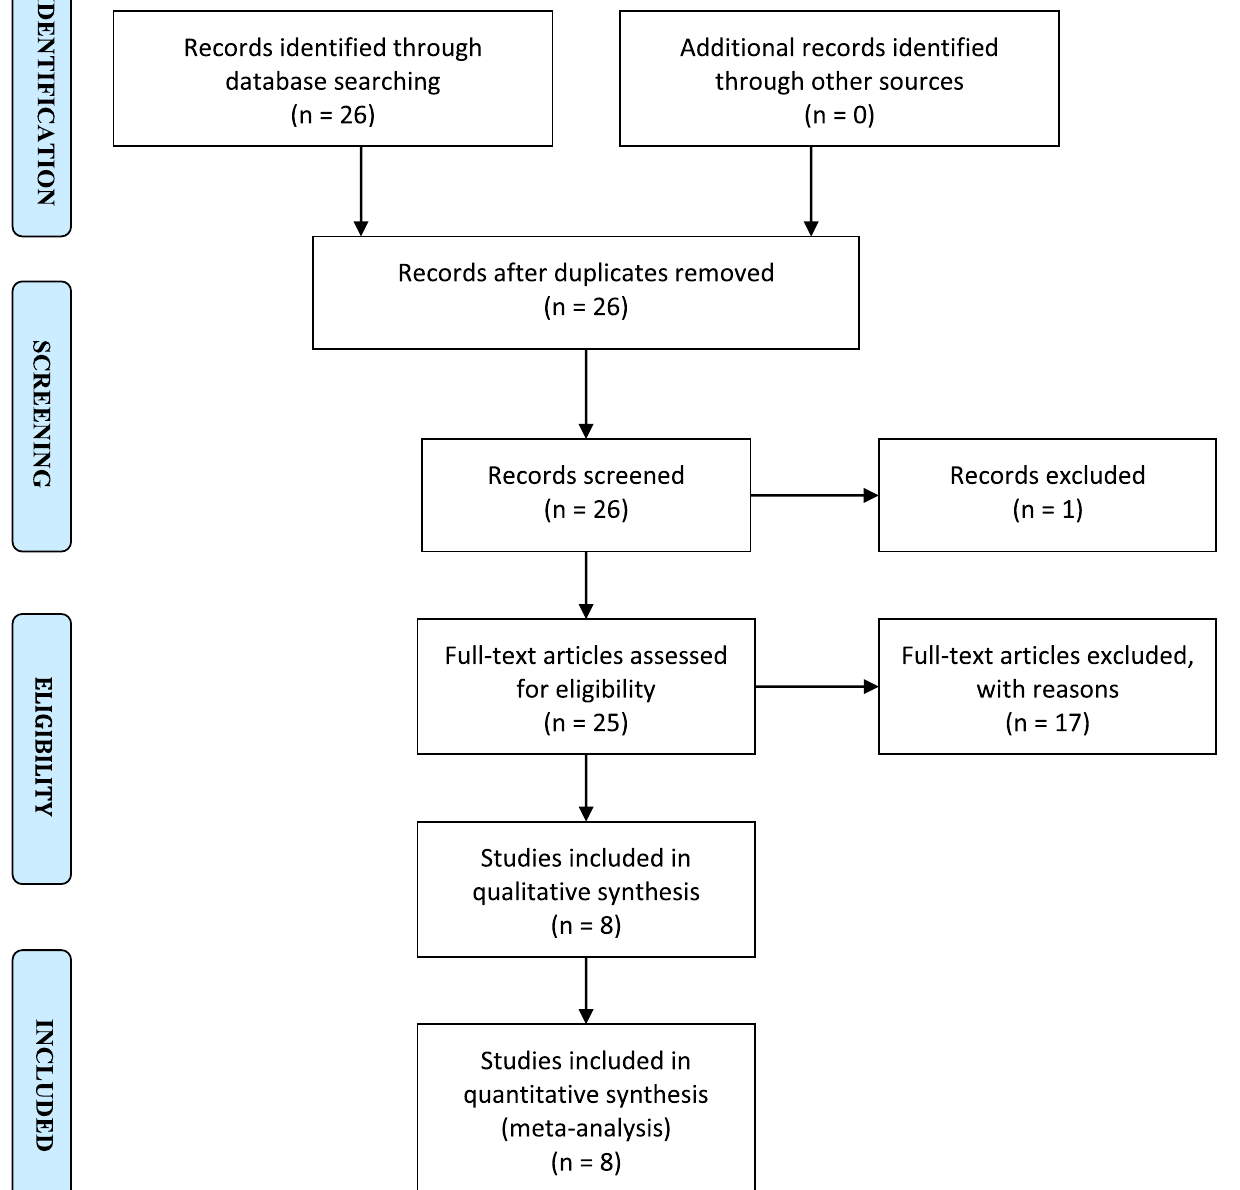
Figure 1. PRISMA fl owchart illustrating the search strategy, number of records screened and